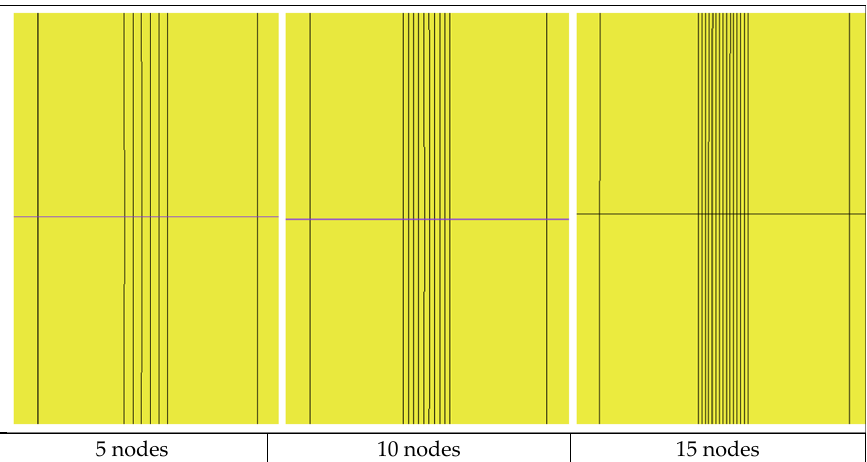
Figure 5. Mesh scheme of the gap in the cooling circuit.